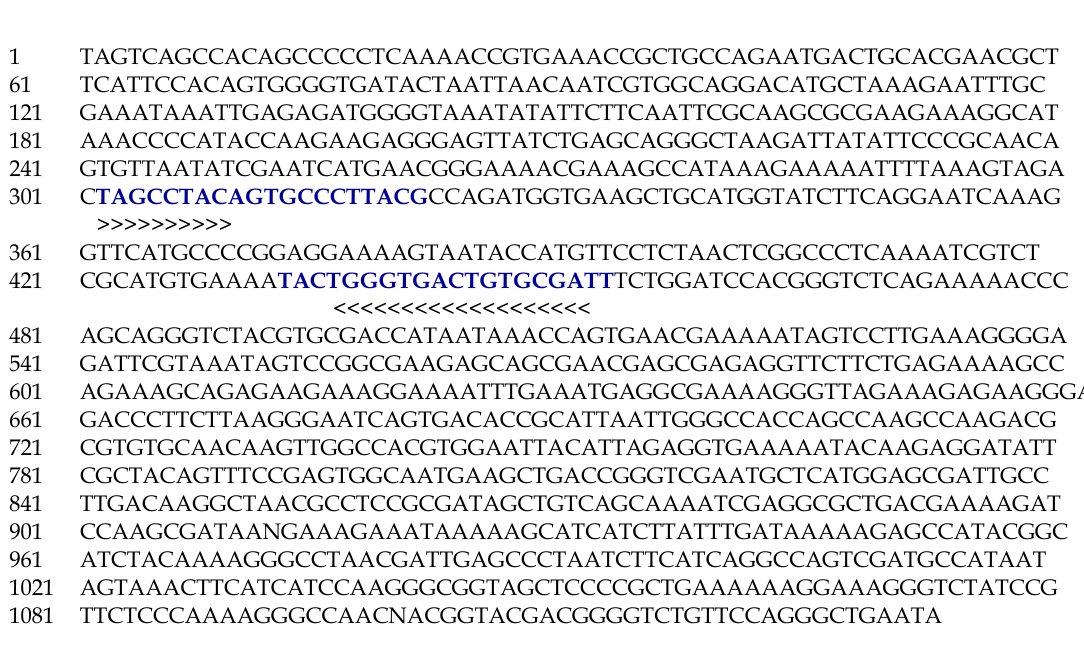
Figure 4. Sequence of cloned RAPD amplicon. Blue colored nucleotides show primer positions. Table 5. Sequence of SCAR primers, PCR condition, and product size.